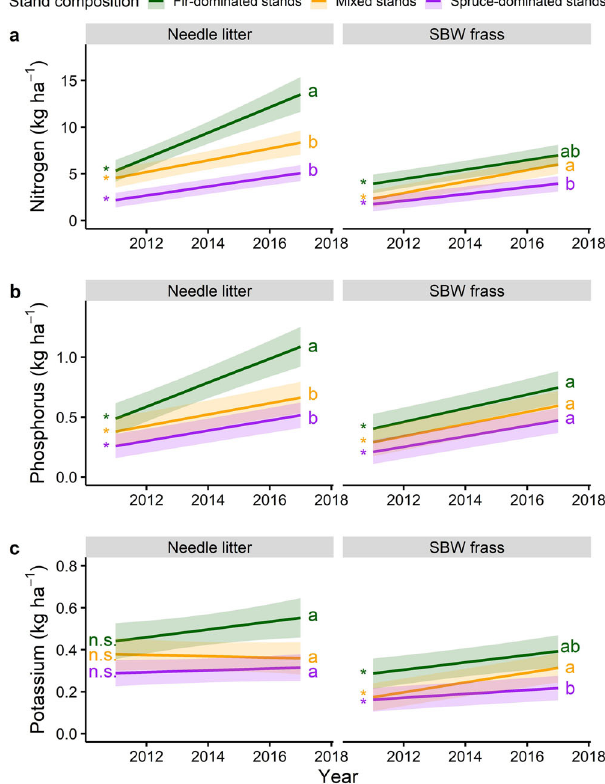
Fig. 3 Litter nutrient fl uxes with annual progression of the outbreak. Fitted relationship for annual nitrogen ( a ), phosphorus ( b ), and potassium ( c ) litter fl uxes (kg ha − 1 ) with time (calendar years) and stand composition for different litter types. Shaded areas indicate 95% con fi dence intervals. Slopes signi fi cantly different from zero are represented by an asterisk and letters compare slopes among stand composition, separately for each litter type. Local basal area was held at its mean value (see Methods section). Linear mixed-effects models were fi tted using a total sample size of 980